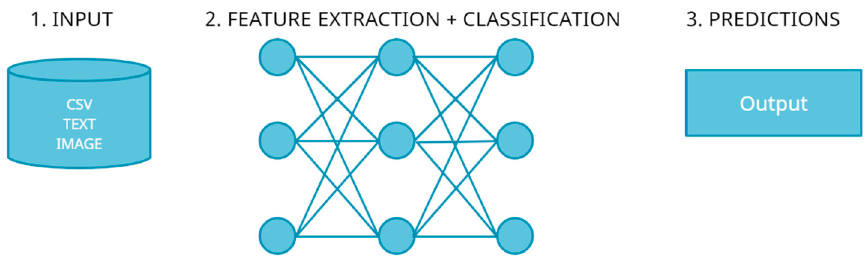
Figure 2. Basic steps involved in deep learning problems.